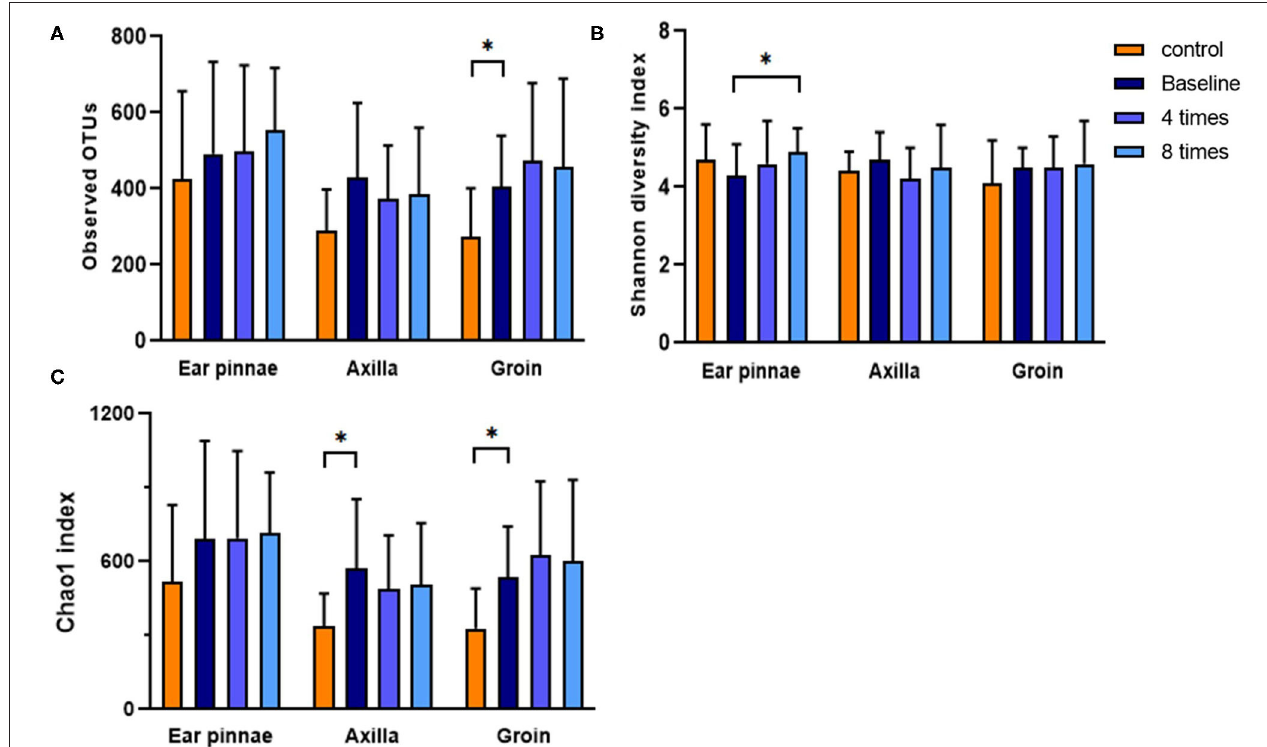
FIGURE 8 | Analysis of diversity of the skin microbiome. Difference in the diversity of the skin microbiome between the control and allergic groups and change in the diversity of the skin microbiome after excimer light therapy in the allergic group. (A) observed OTUs. (B) Shannon diversity index. (C) Chao 1 index. Four times, fourth session of excimer light therapy in allergic group; eight times, end of the excimer light therapy in allergic group; baseline, before start of excimer light therapy in allergic group; OTUs, operational taxonomic units). All values are expressed as means ± standard error. * P <